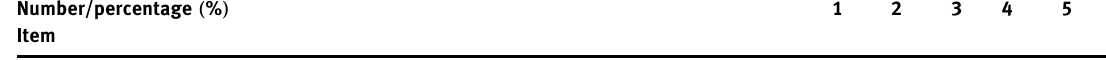
Table 6: Students ’ understanding of English writing learning after the experiment Number/percentage ( %